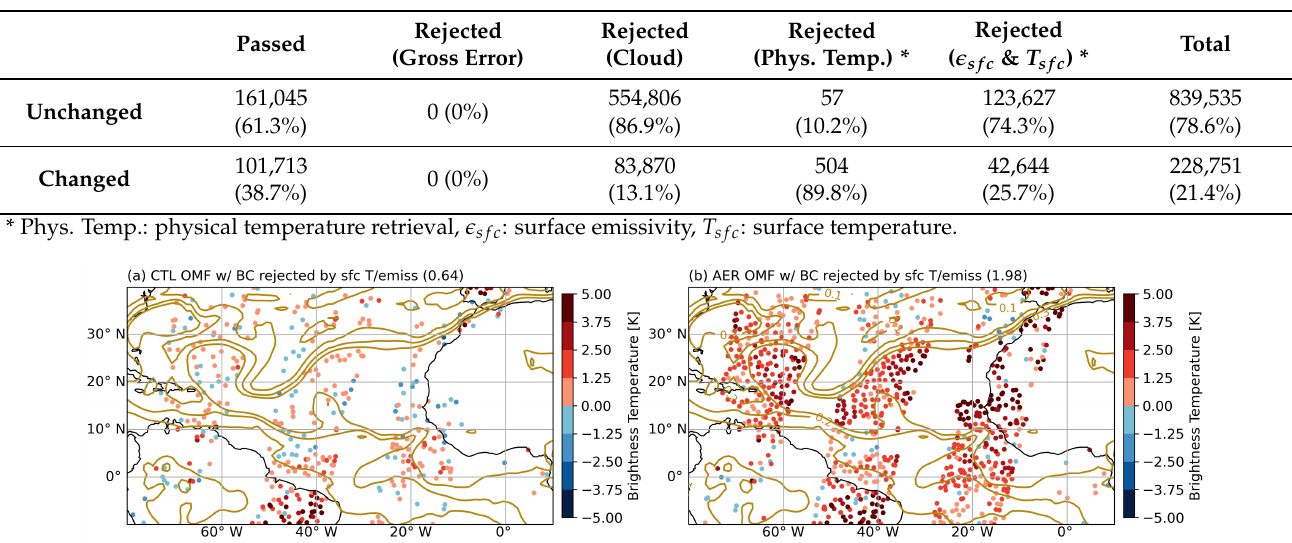
Figure 9. The distribution of rejected OMFs due to surface emissivity and temperature check for ( a ) CTL and ( b ) AER at the cycle of 12Z 5 August 2017. The data count is shown in the title of each panel. The AOD at 550 nm contour lines of 0.1, 0.2, and 0.3 are plotted in